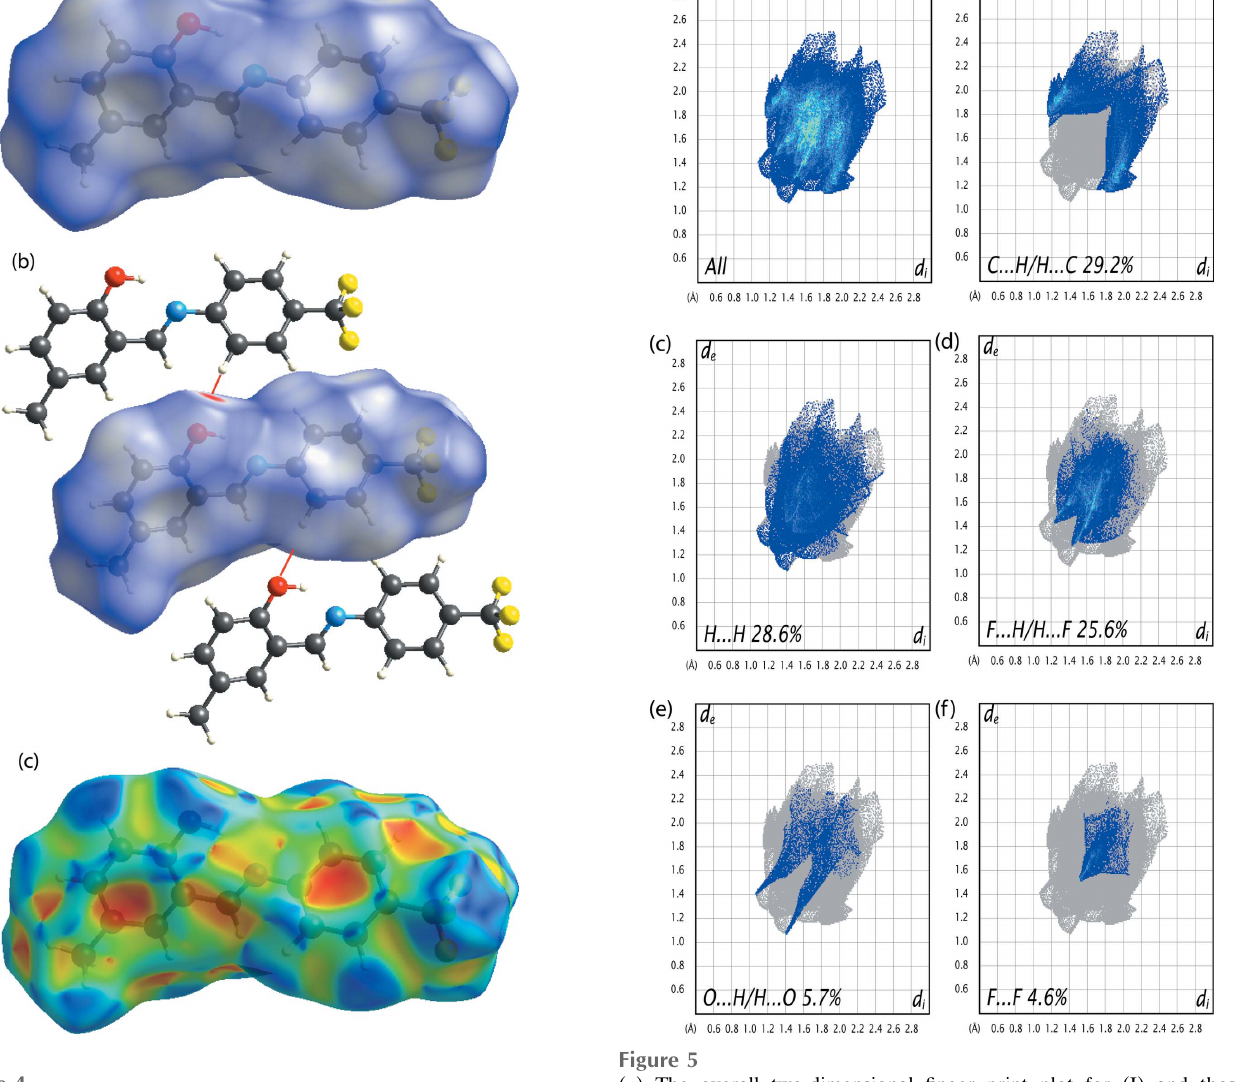
Figure 4 A view of the Hirshfeld surface of (I) mapped over ( a ) d norm , ( b ) intermolecular C—H (cid:2)(cid:2)(cid:2) O interactions and ( c ) shape-index.